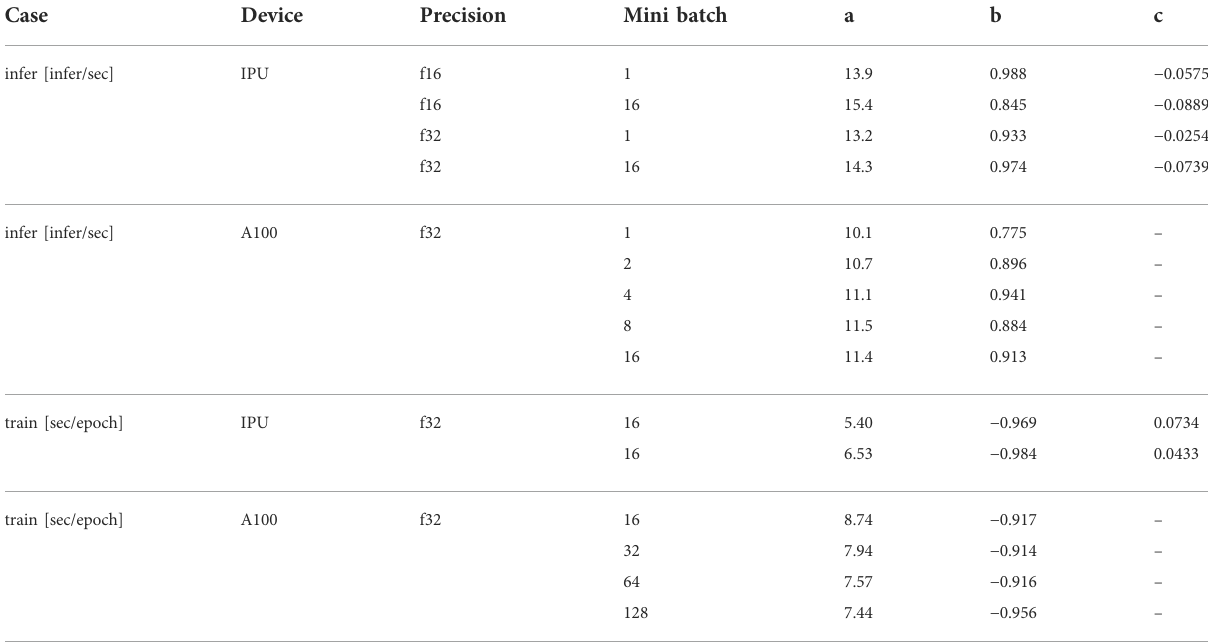
TABLE 2 Coef fi cients for the following general formula described in Eqs. 3 and 7. The curves follow along the constant mini batch (mb) such that the global batch size = mb × η . Note that only four or less evaluation points for the A100 case require we fi t only coef fi cients a and b . Case Device